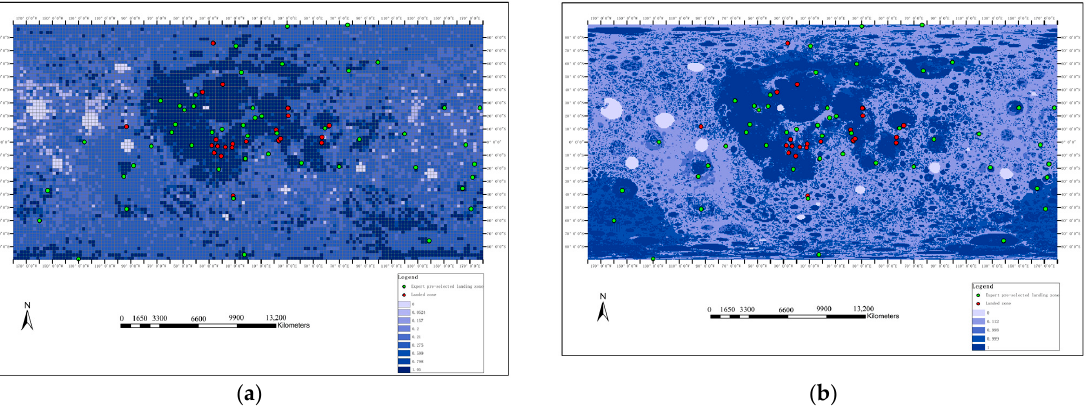
Figure 8. Posterior probability results of different cell grid ranges. ( a ) 72 × 144 cells; ( b ) 288 × 576 cells. Table 2. The statistical results of the posterior probability statistics of the whole-moon landing zone selection based on weights of evidence and fractals. (288 × 576).